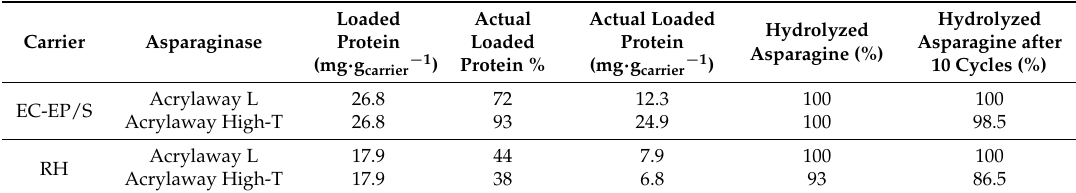
Table 4. Properties of the two asparaginase immobilized covalently on the functionalized rice husk and on EC-EP/S resins. The enzyme performance was determined by evaluating the amount of asparagine hydrolyzed after 30 min of incubation at 40 ◦